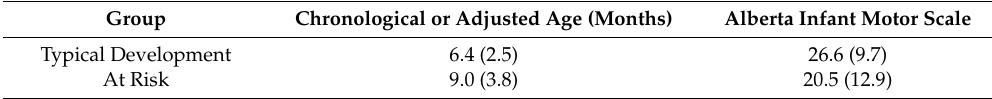
Table 1. Participant Characteristics (Mean and Standard